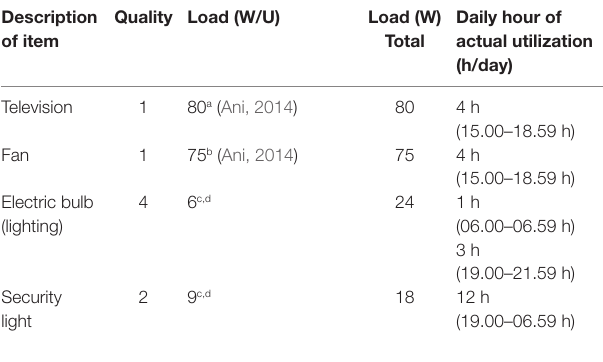
FigUre 2 | Daily load variation of the household . TaBle 1 | energy needed for the household use.